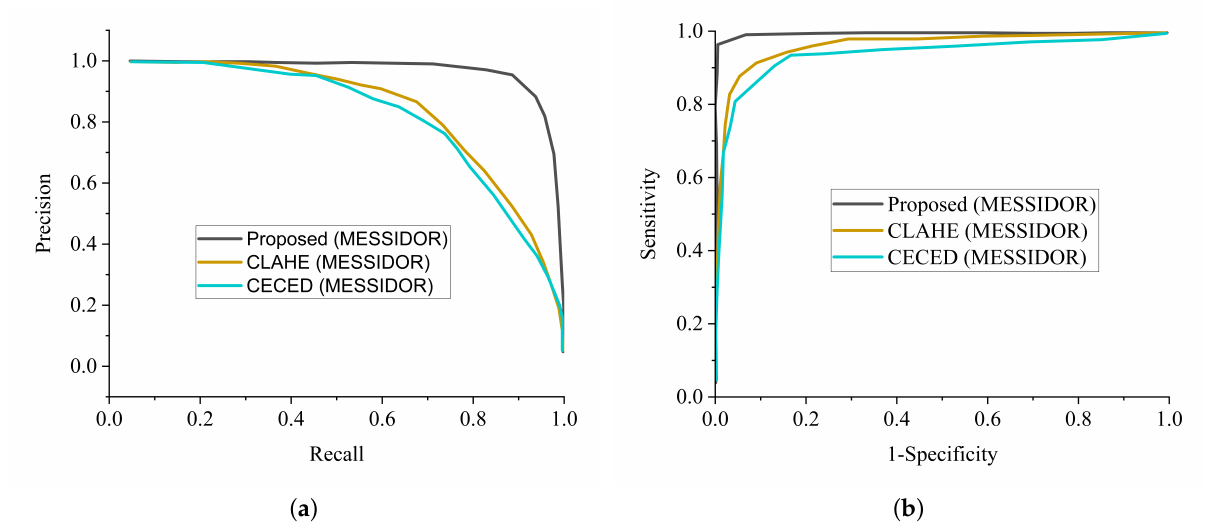
Figure 12. Comparison report of our model with single-channel models on the Messidor dataset. ( a ) Precision-recall curve for our proposed model in comparison with a single-channel model on the Messidor dataset. ( b ) ROC curve for our proposed model in comparison with a single-channel model on the Messidor dataset.